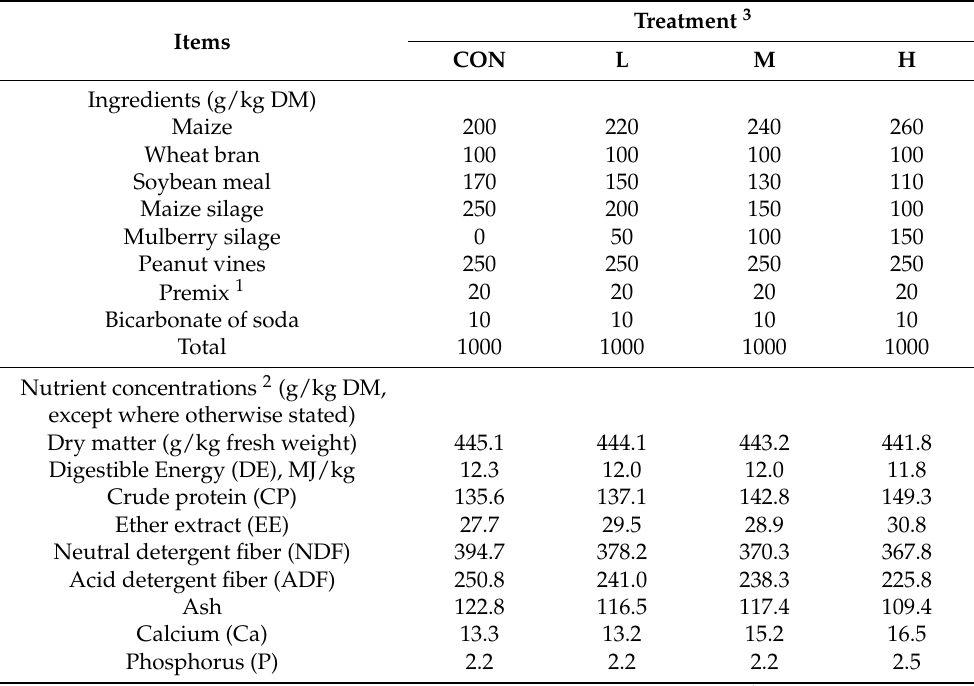
Table 1. Composition and nutrient levels of basal